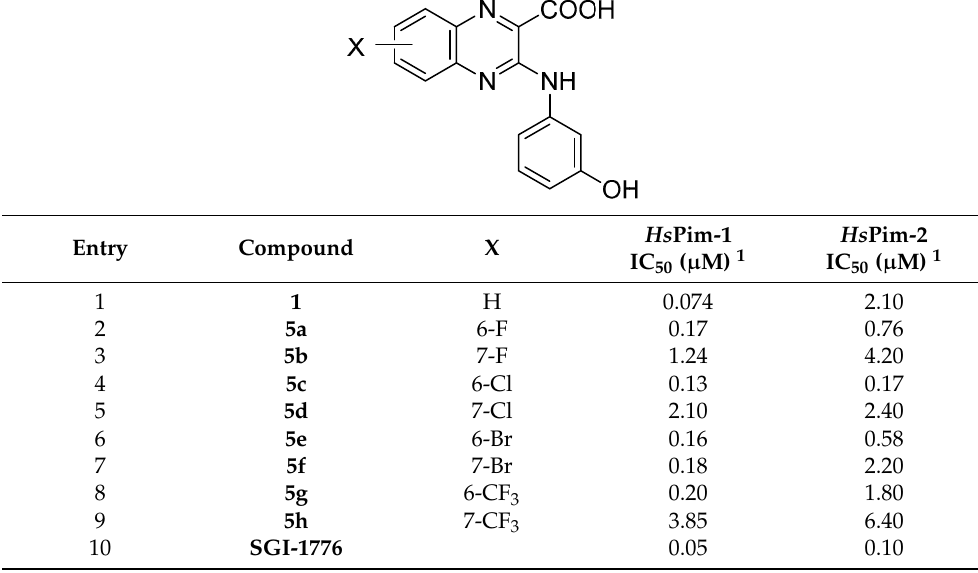
Molecules 2021 , 26 , x FOR PEER REVIEW 6 of 22 Figure 3. Oak Ridge Thermal ‐ Ellipsoid Plot Program (ORTEP) drawing of substituted ‐ quinoxaline ‐ 2 ‐ carboxylic acids 5b , 5d and 5e with thermal ellipsoids at 30% level [32]. 2.2. Enzymatic Assays 2.2.1. Pim ‐ 1 and Pim ‐ 2 Enzymatic Activity Inhibition Synthesized compounds were first evaluated for their ability to inhibit the in vitro enzymatic activity of Homo sapiens Pim ‐ 1 ( Hs Pim ‐ 1) and Hs Pim ‐ 2, using a luminescence ‐ based kinase assay [33]. SGI ‐ 1776, a small ‐ molecule pan ‐ Pim protein kinase inhibitor [18],